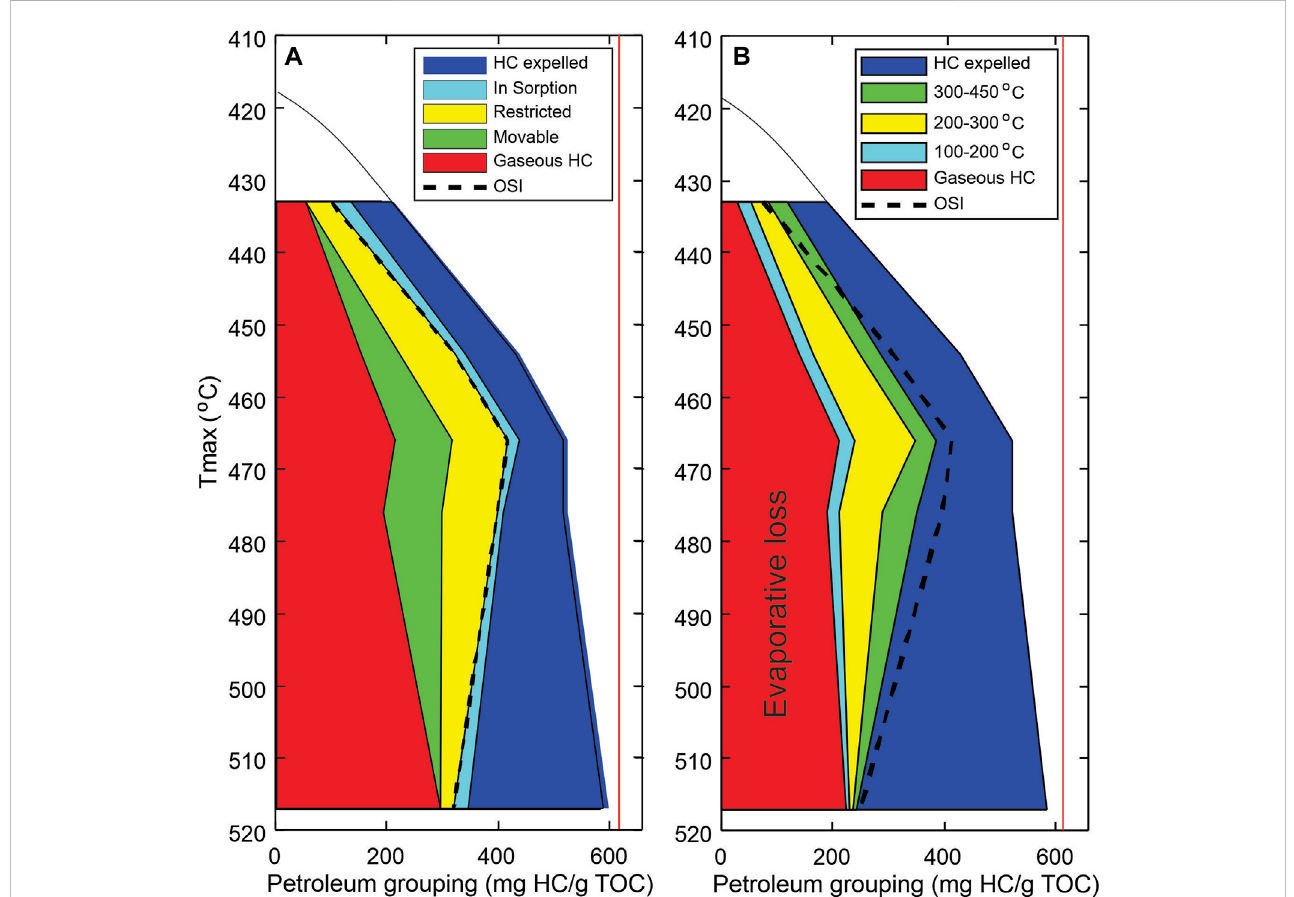
FIGURE 10 Petroleum fl uid composition grouping and mobility estimation in shale petroleum reservoir, Duvernay Formation in WCSB. (A) resource grouping based on petroleum fl uid mobility assessment in reservoir (phase behaviors and OSI); (B) petroleum compositional grouping (boiling temperature range equivalent) inverted from kinetic models. Oil saturation index: OSI=S1/TOCx100. The evaporative loss includes gaseous hydrocarbons and light oils that have been generated and retained in the shale, but lost prior to the sample